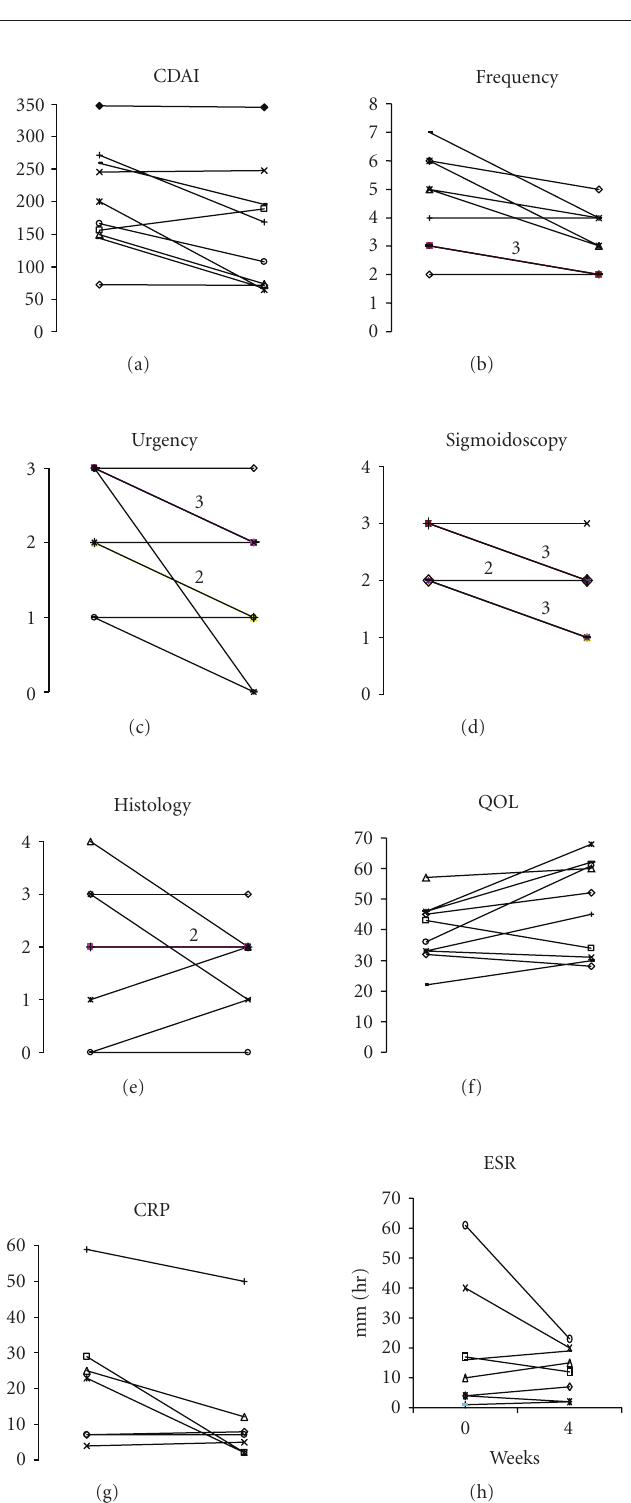
Figure 1: Outcome measures. Response of 10 patients with active Crohn’s colitis given 6mg nicotine enemas daily for 4 weeks. Where 2 or 3 patients had the same baseline and end values, this is indicated above the connecting line, which is drawn more boldly. CDAI is Crohn’s disease activity index. Frequency is the number of stools/24 hours. Urgency of defaecation is graded: 0 = none, 1 = mild, 2 = moderate, and 3 = severe enough to cause incontinence. Sigmoidoscopic score is graded 0, normal to 4, fulminant disease. Histological scores are based on acute inflammatory activity: grade 0, no polymorphs to grade 4, florid acute inflammation with polymorphs and ulceration. Histology data is given for only 8 patients because the end-of-study biopsies of 2, both with baseline scores of 2, were insu ffi cient for analysis. QOL is a score of quality of life as measured by the short inflammatory bowel disease questionnaire [21]. Paired data were available for CRP in 7 patients and for ESR in 8